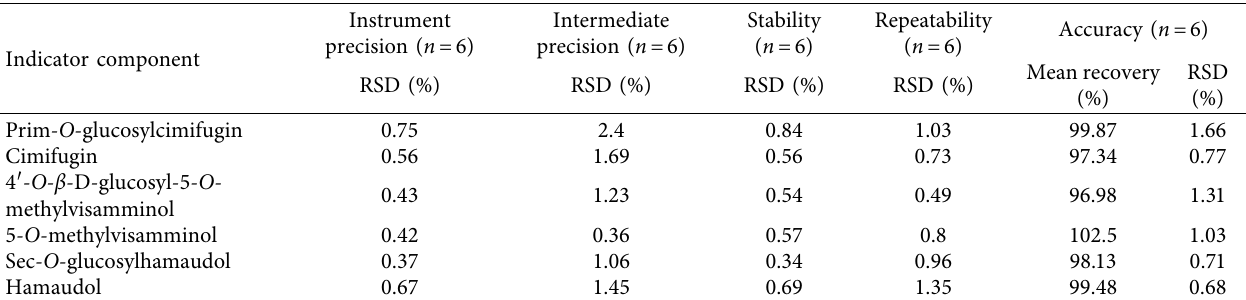
Table 2: Instrument precision, intermediate precision, stability, repeatability, and recovery of six analytes. Indicator